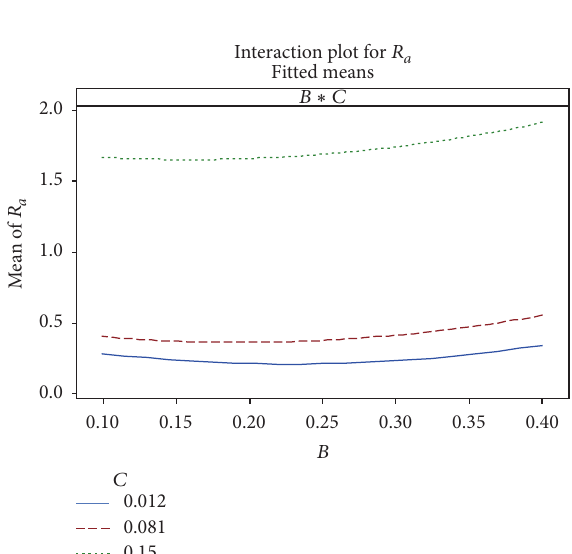
Figure 5: Optimization plot for 𝑅 𝑎 .